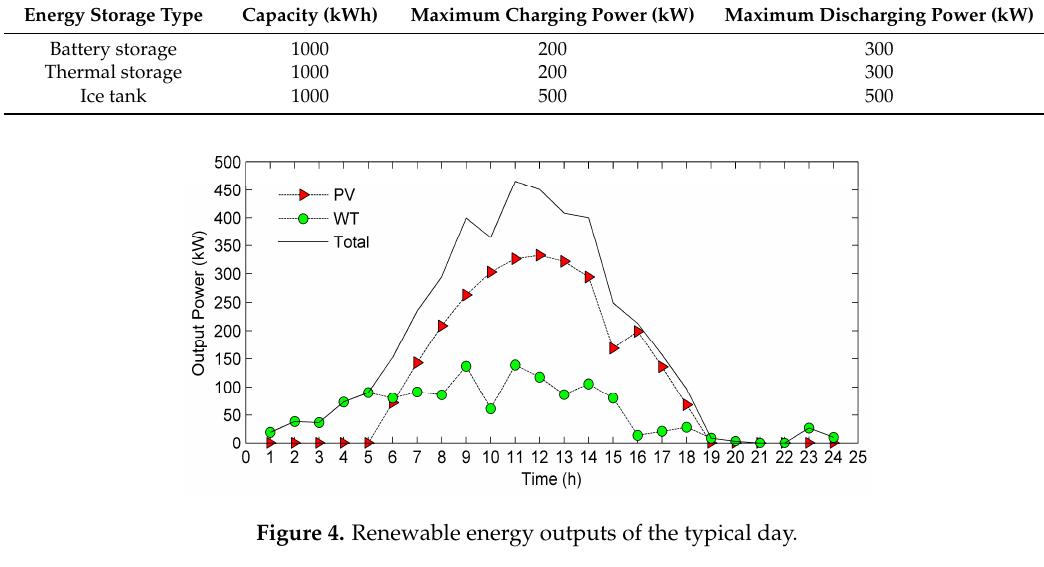
Figure 4. Renewable energy outputs of the typical day.